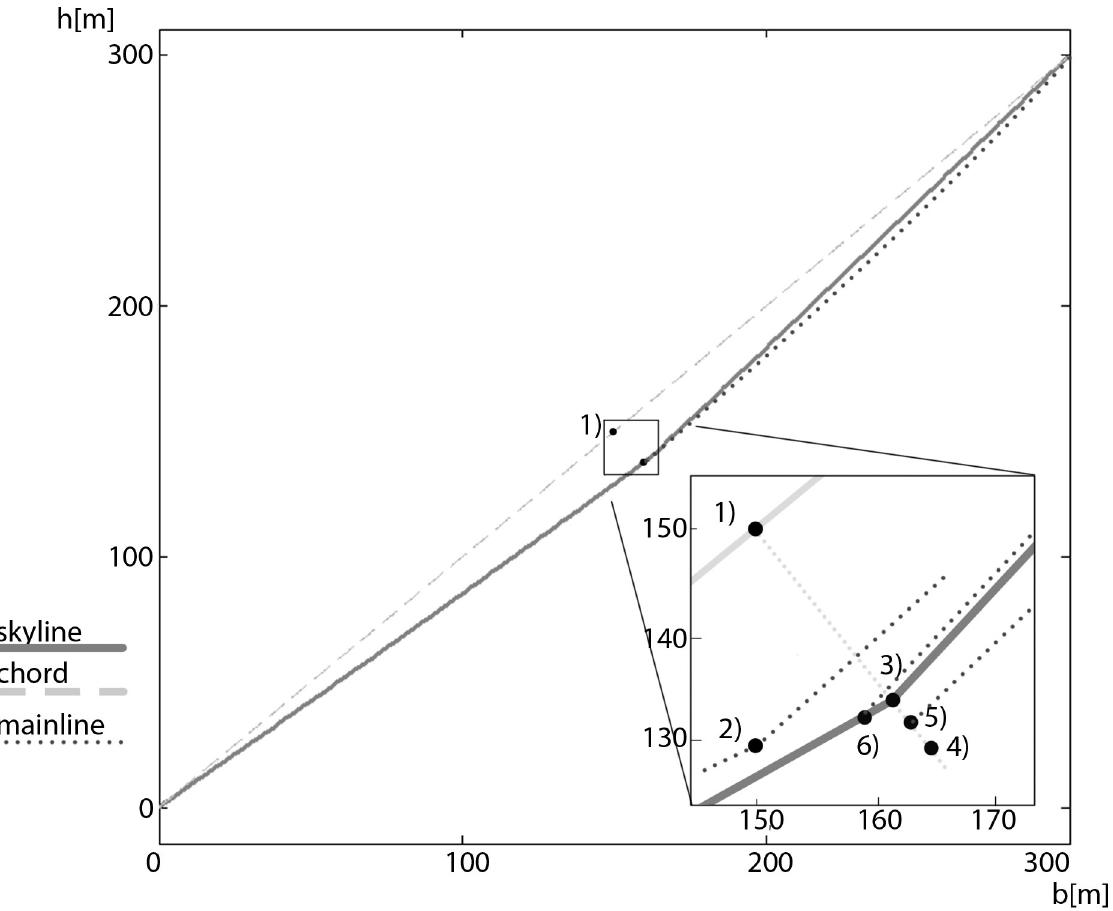
Fig 5. Sag with carriage at midspan position in an inclined single-span